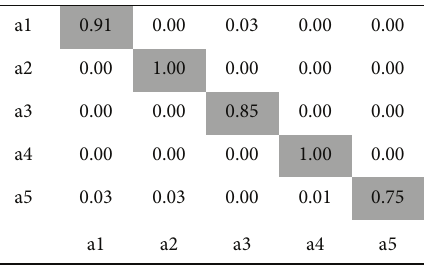
Figure 5: Confusion matrix for KTH data